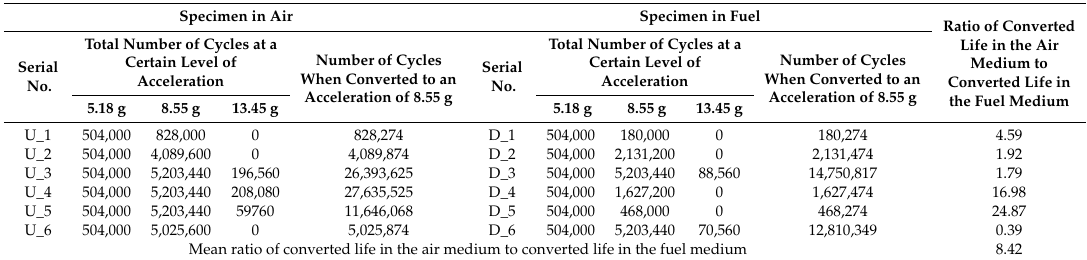
Table 8. Life at an acceleration of 8.55 g converted from the test life at accelerations of 5.18 g and 13.45